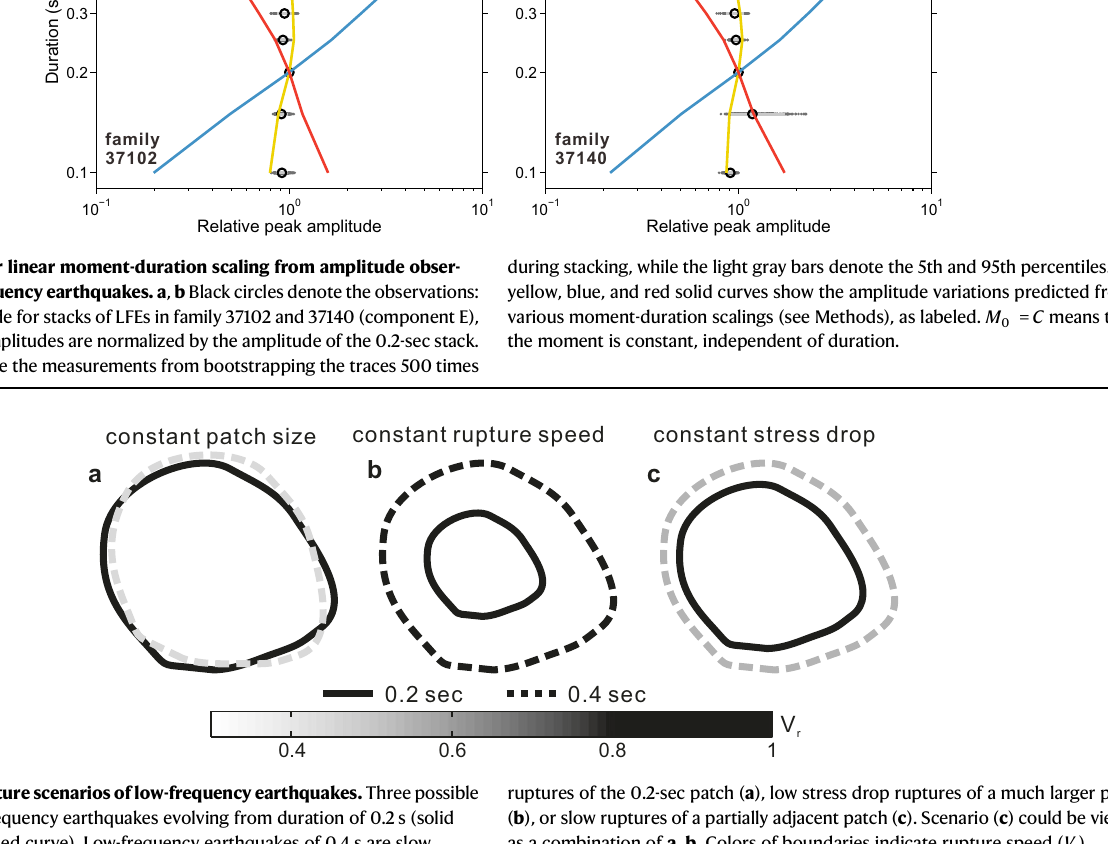
Fig.7|Possiblerupturescenariosoflow-frequencyearthquakes. Threepossible scenarios for low-frequency earthquakes evolving from duration of 0.2s (solid curve) to 0.4s (dashed curve). Low-frequency earthquakes of 0.4s are slow